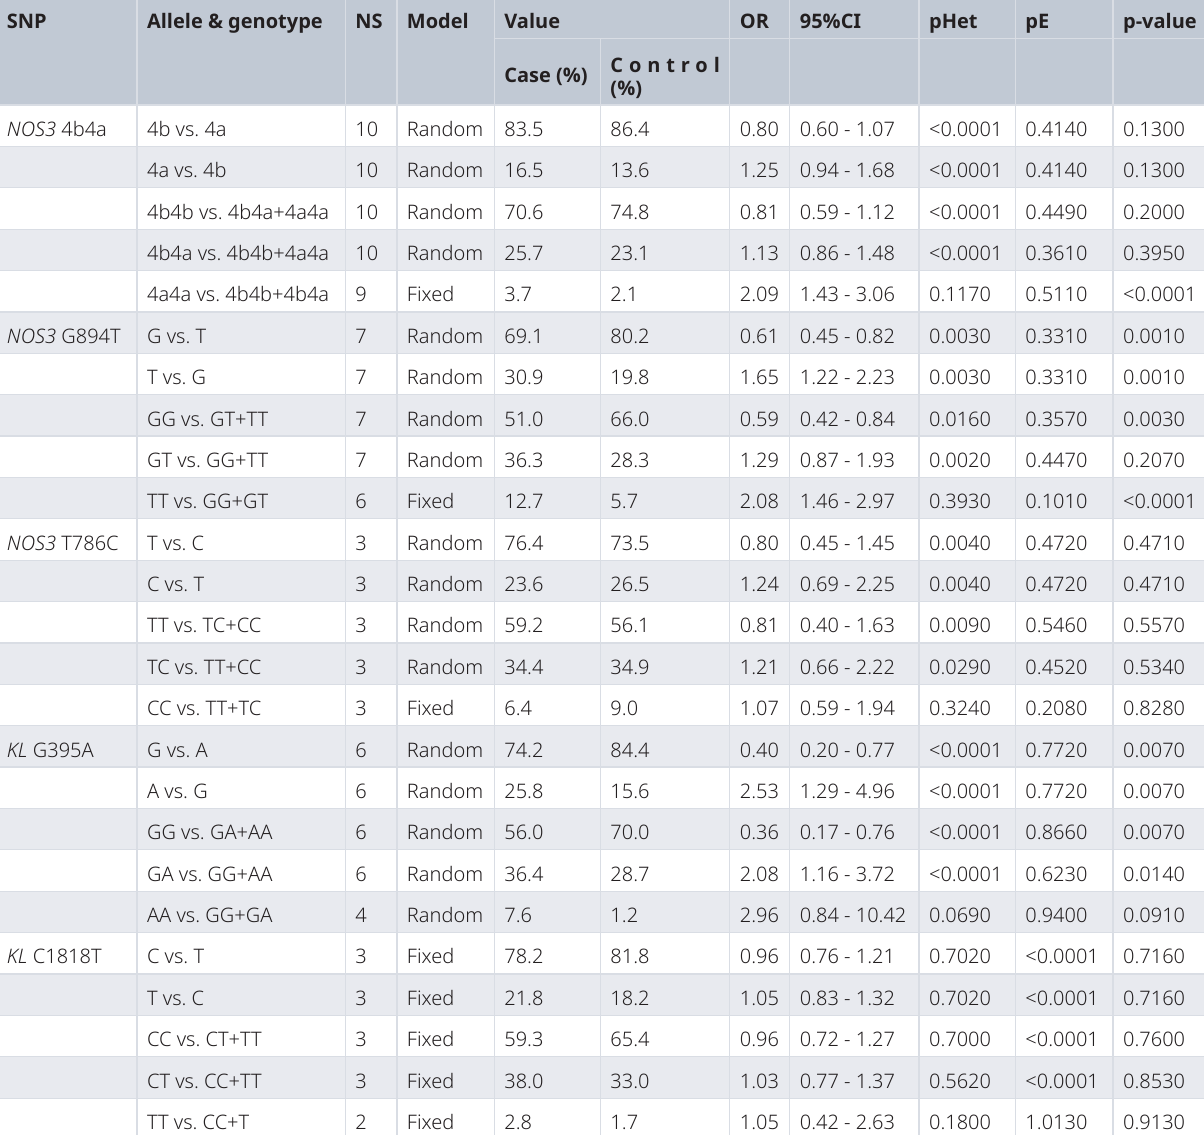
Table 2. Summary of the association between the risk of CKD and both NOS3 and KL gene polymorphisms. SNP Allele &